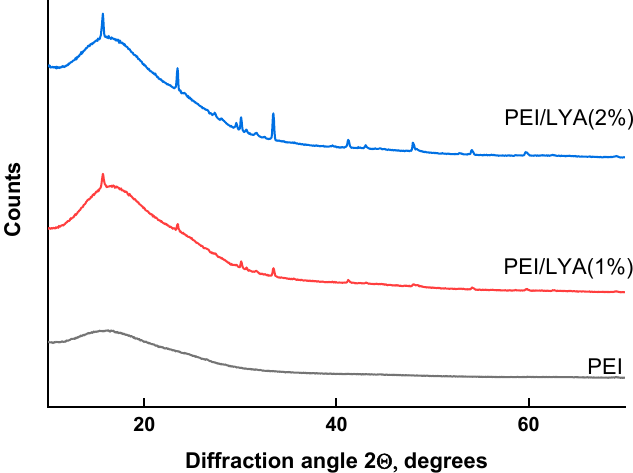
Figure 5. XRD patterns of pure PEI and PEI/LYA membranes.